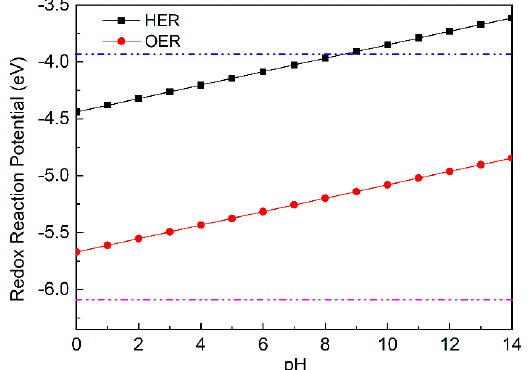
Figure 5. The potentials of the OER and HER of the water splitting as a function of the pH value with respect to the band edge positions of the WSSe/BSe vdW heterostructure.